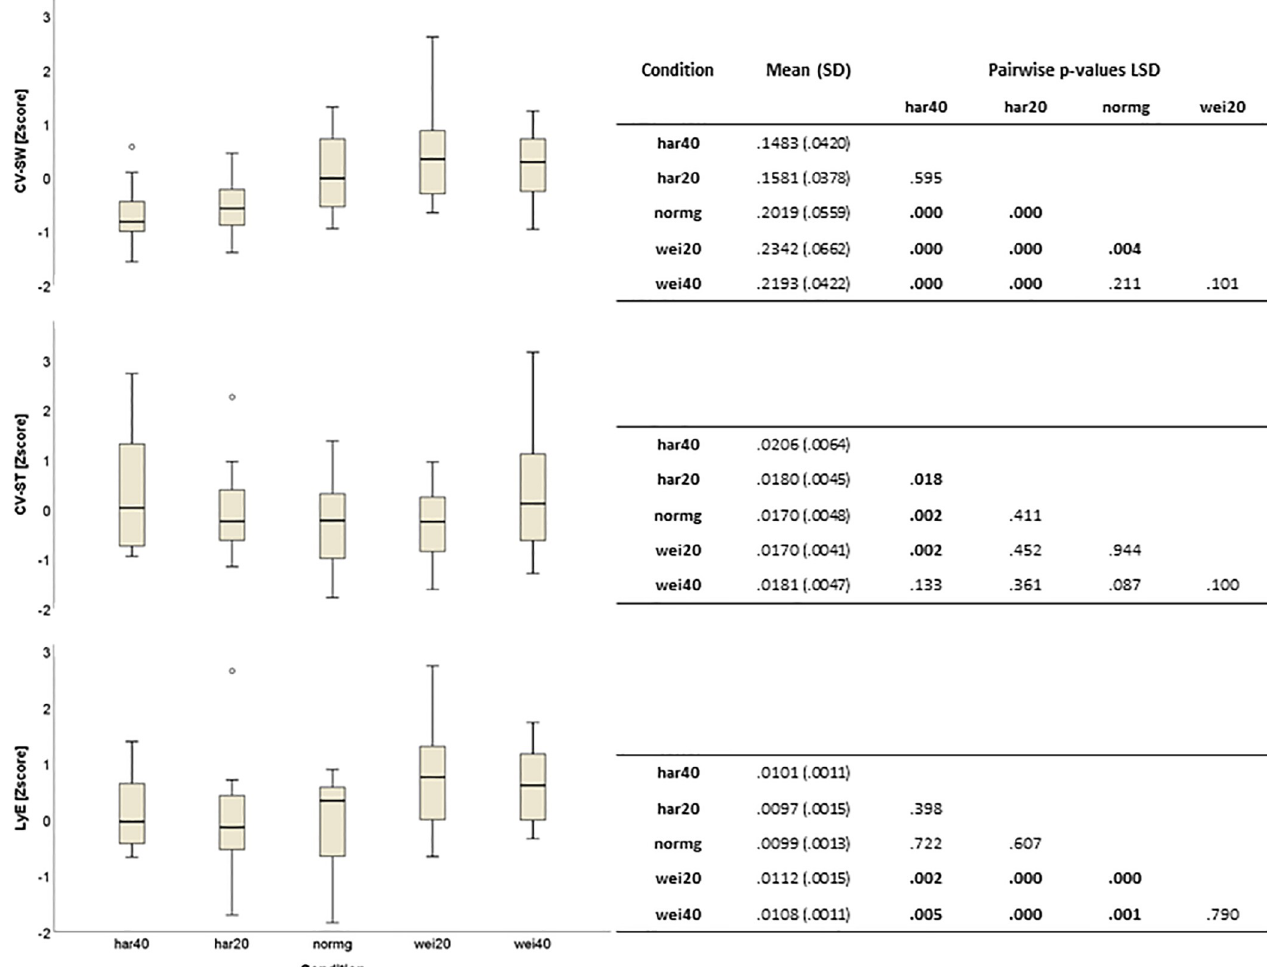
Fig 2. Effect of the walking conditions on the three main outcome parameters: CV-SW, CV-ST and LyE. Mean (SD) in the table are in units of the outcome, for CV-SW and CV-ST in %, for LyE the exponent value. Bold p-values indicate significance at 5% alpha level in the LSD post-hoc test.